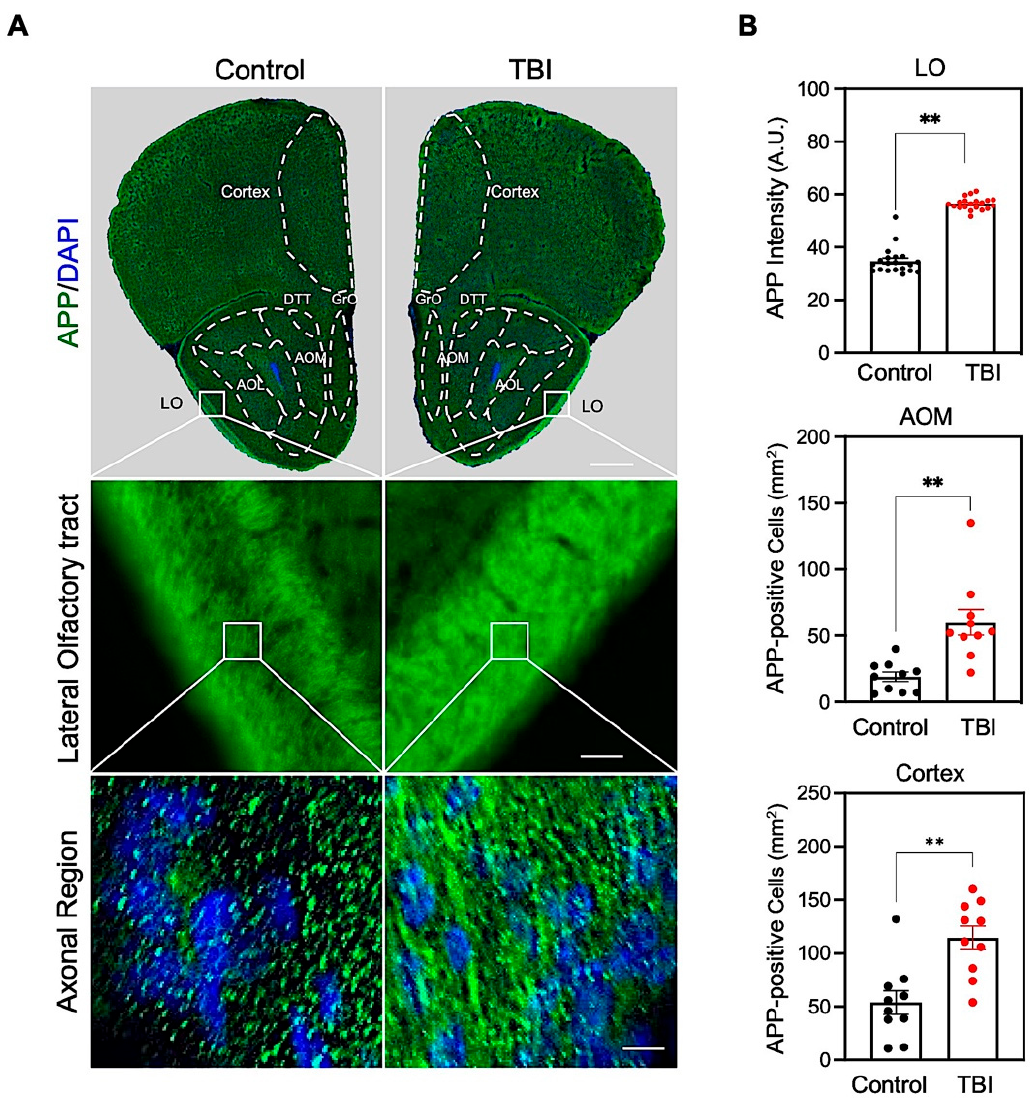
Figure 2. Olfactory ‐ bulb ‐ associated areas exhibit increased amyloid protein precursor (APP) level in TBI mice. ( A ) Representative hemisphere images of the olfactory bulb region ( top panel ), lateral olfactory (LO) tract region ( middle panel ), and high magnification of LO regions in control and TBI mice (bottom panel). Scale bars (white): 500 μ m ( top ), 200 μ m ( middle ), and 10 μ m ( bottom ). ( B ) Densitometry analysis showed a significant increase of APP level and APP ‐ positive cell number in repetitive TBI mice compared to control mice (control, N = 5; TBI, N = 5). Error bars indicate SEM; **, significantly different from control at p < 0.01.